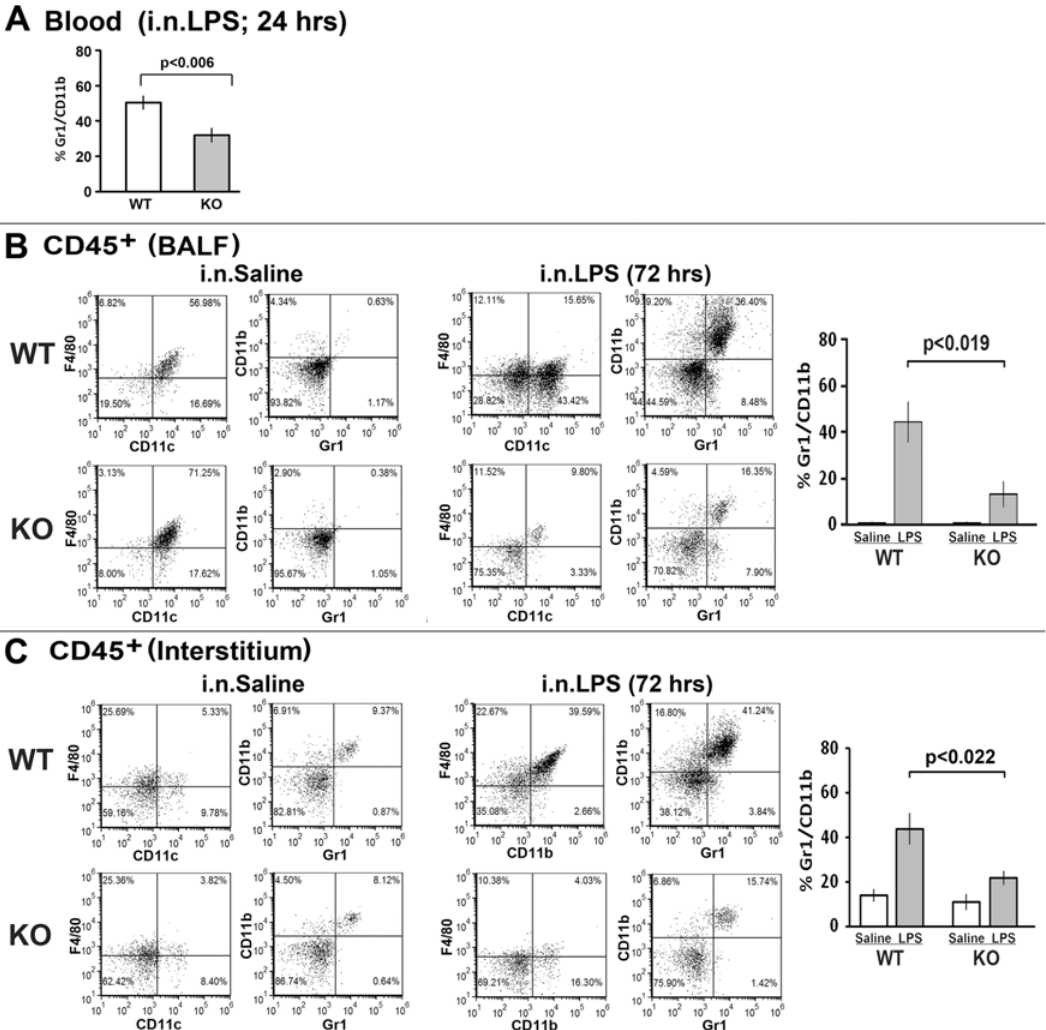
Fig 3. The α 7 knock-out ( α 7 KO ) mice do not elicit a normal lung inflammatory response upon i.n. challenge with LPS. Mice ( α 7 WT or α 7 KO ) were i.n. challenged with LPS (250 μ g/mouse in 30 μ l Saline) or saline (30 μ l per mouse). For all experiments the bar graphs on the right represent quantification of the results from three independent experiments (12 animals (4 – 5 mice per experimental group) total per α 7 WT or α 7 KO genotypes, respectively) with error bars representing the standard error of the mean (SEM). Statistical significance was determined with the Student ’ s t-test. (A) 24 hours post-challenge small samples of blood (50 μ l) were collected and assessed for CD11b + Gr1 + cells. In terms of circulating cells in the blood, the α 7 KO exhibited an overall reduced number. To measure the lung, mice were sacrificed 3 days after LPS-challenge and BALF (B) and interstitial cells (C) were isolated and measured (see Fig. 2 and the Methods). The total number of cells isolated from the BALF of saline treated (i.n.) WT and α 7 KO mice was similar (360,000 from the WT mice and 320,000 from the α 7 KO mice). However, upon LPS challenge the number of cells isolated from WT BALF increases to an average of 740,000 cells/mouse in comparison to 450,000 cells from the BALF of the α 7 KO mouse (n = 4 mice per group). These cells were stained for CD45, F4/80, CD11c, CD11b and Gr1 markers and analyzed by FACS. Flow cytometry data for isolated interstitial cells was gated on CD45 + cells. In the interstitium, similar to the BALF, fewer CD45 + cells were obtained from the α 7 KO mouse (2.2 x 10 6 cells from the WT versus 0.9 x 10 6 cells from the α 7 KO ). Virtually all cells in the BALF are CD45 + .